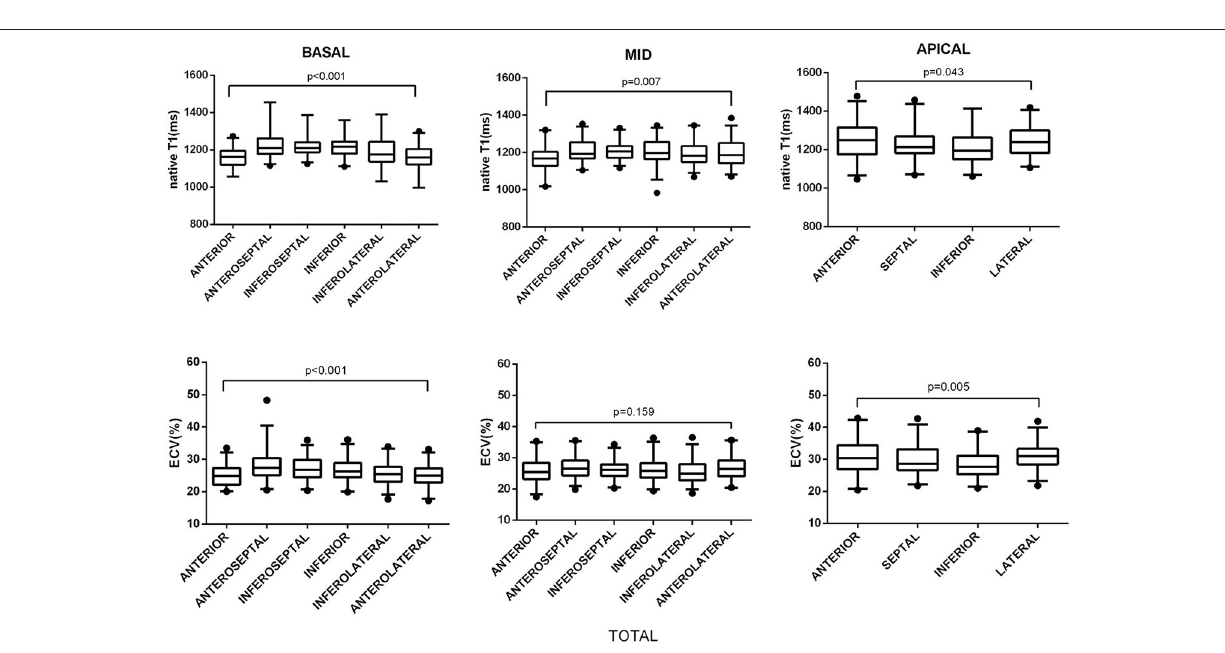
FIGURE 2 | Segmental variations of native T1 value and ECV by slice location. The central box represents the values from the lower to the upper quartile. The middle line shows the median. The whiskers range from the minimum to the maximum value excluding outliers, which are shown as dots. Differences in native T1 and ECV between segments were analyzed using the Kruskal–Wallis